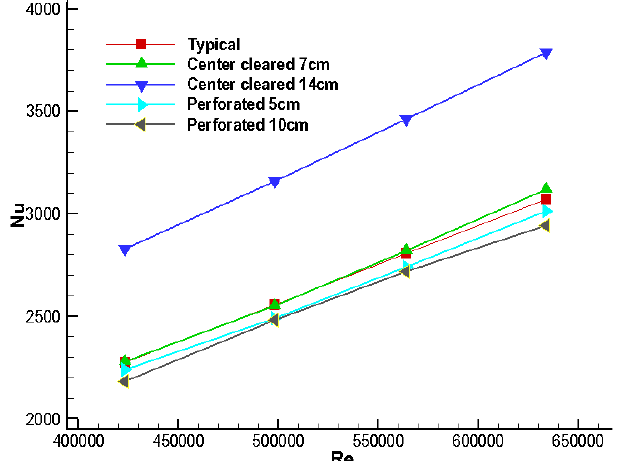
Fig. 11. Variation of Nusselt number at different Reynolds numbers Fig .11 Variation of Nusselt number at different Reynolds numbers